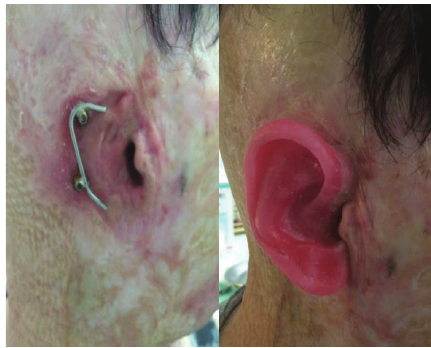
Figure 2: When the process of osseointegration is complete, the prostheses, which also have clips, are easily and securely attached to or removed from the gold-platinum cylinder-and-bar system.